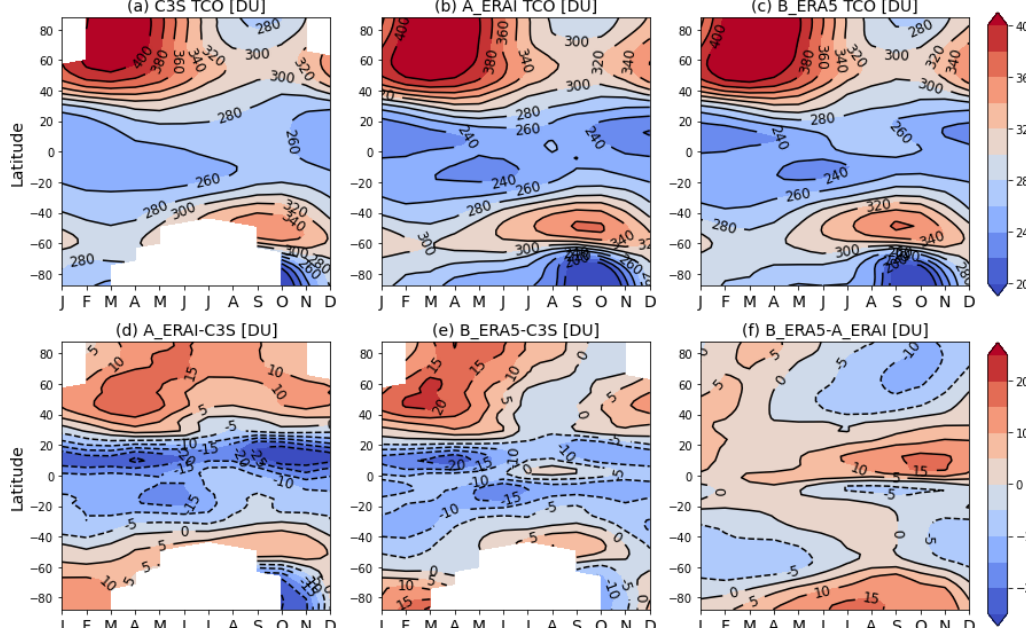
Figure 2. Zonal and monthly mean TCO (DU) climatology over the period 1979–2018, based on (a) C3S and two model simulations (b) A_ERAI and (c) B_ERA5. The absolute differences between each simulation and C3S, and between the two simulations, are shown in